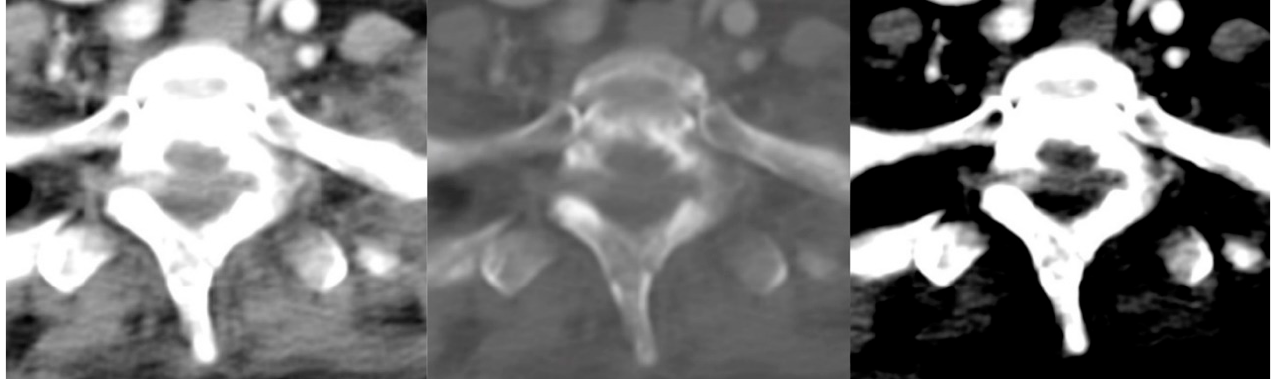
Figure 4. Axial CT image of the cervicothoracic junction overcalled as low-grade epidural disease by two radiologists. No epidural disease was present on the corresponding MRI (not shown). Assessment is complex due to overlap and angulation of the lower cervical and upper thoracic spine in the axial plane with background degenerative changes.